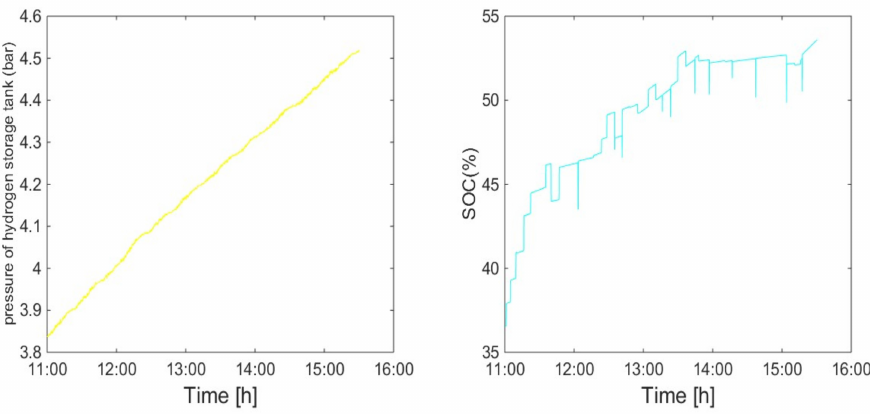
Figure 12. Operation state curves in scenario